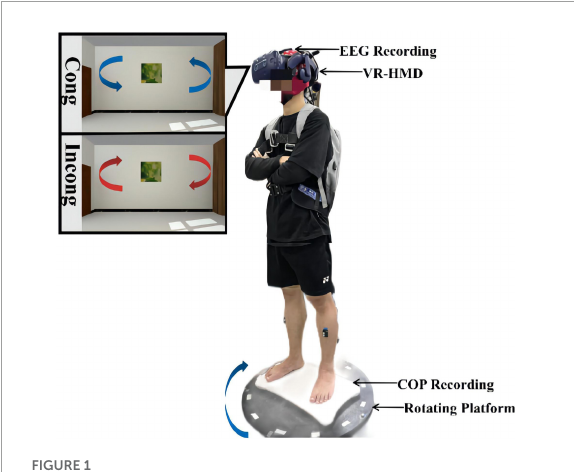
FIGURE1 Schematic diagram of the experimental setup and installation. The experimental system was composed of an EEG acquisition device, a VR headset, a force measurement platform, and a rotating platform. During the experiment, the participants stood on the force measurement platform and were asked to look straight ahead with their hands on their chests the whole time. Both physical and visual distractions were applied through the rotating platform and the VR headset. The rotation was always clockwise, while the visual scene was rotated counterclockwise at the same speed in the congruent condition and clockwise at the same speed in the incongruent